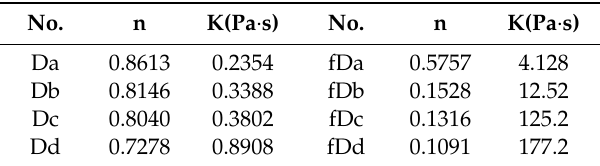
Table 2. Parameters of KGM sols with different amount of alkali dealt before and after freezing treatment estimated by Power law equation.